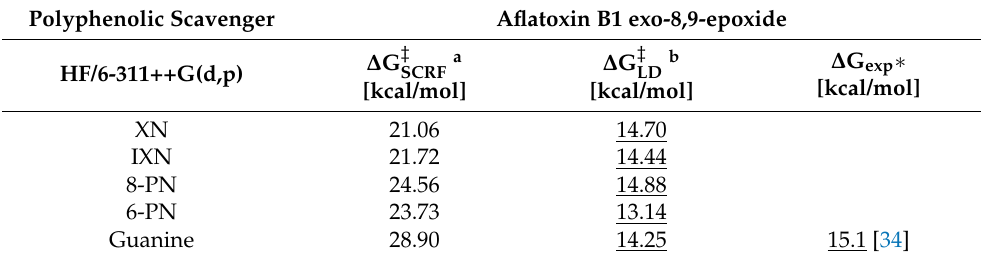
Table 1. Activation free energies ( ∆ G ‡ ) obtained at the HF/6-311++G(d,p) level of theory in conjunc- tion with SCRF and LD implicit solvation models for the reactions of AFBO with XN, IXN, 8-PN, 6-PN, and